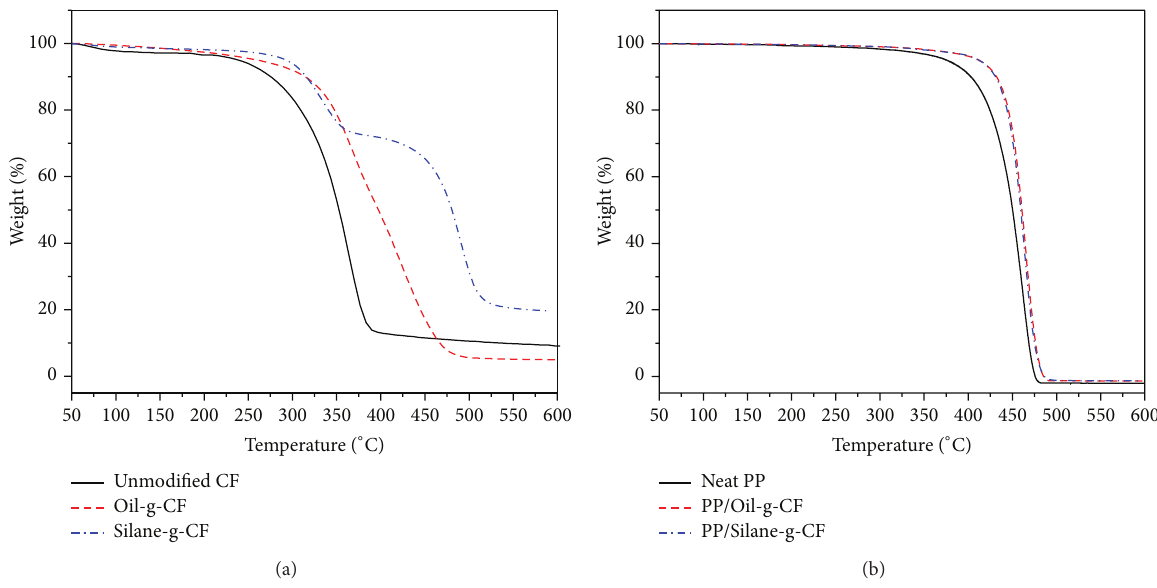
Figure 7: TG thermograms of (a) CF, Oil-g-CF, and Silane-g-CF and (b) neat PP, PP/Oil-g-CF, and